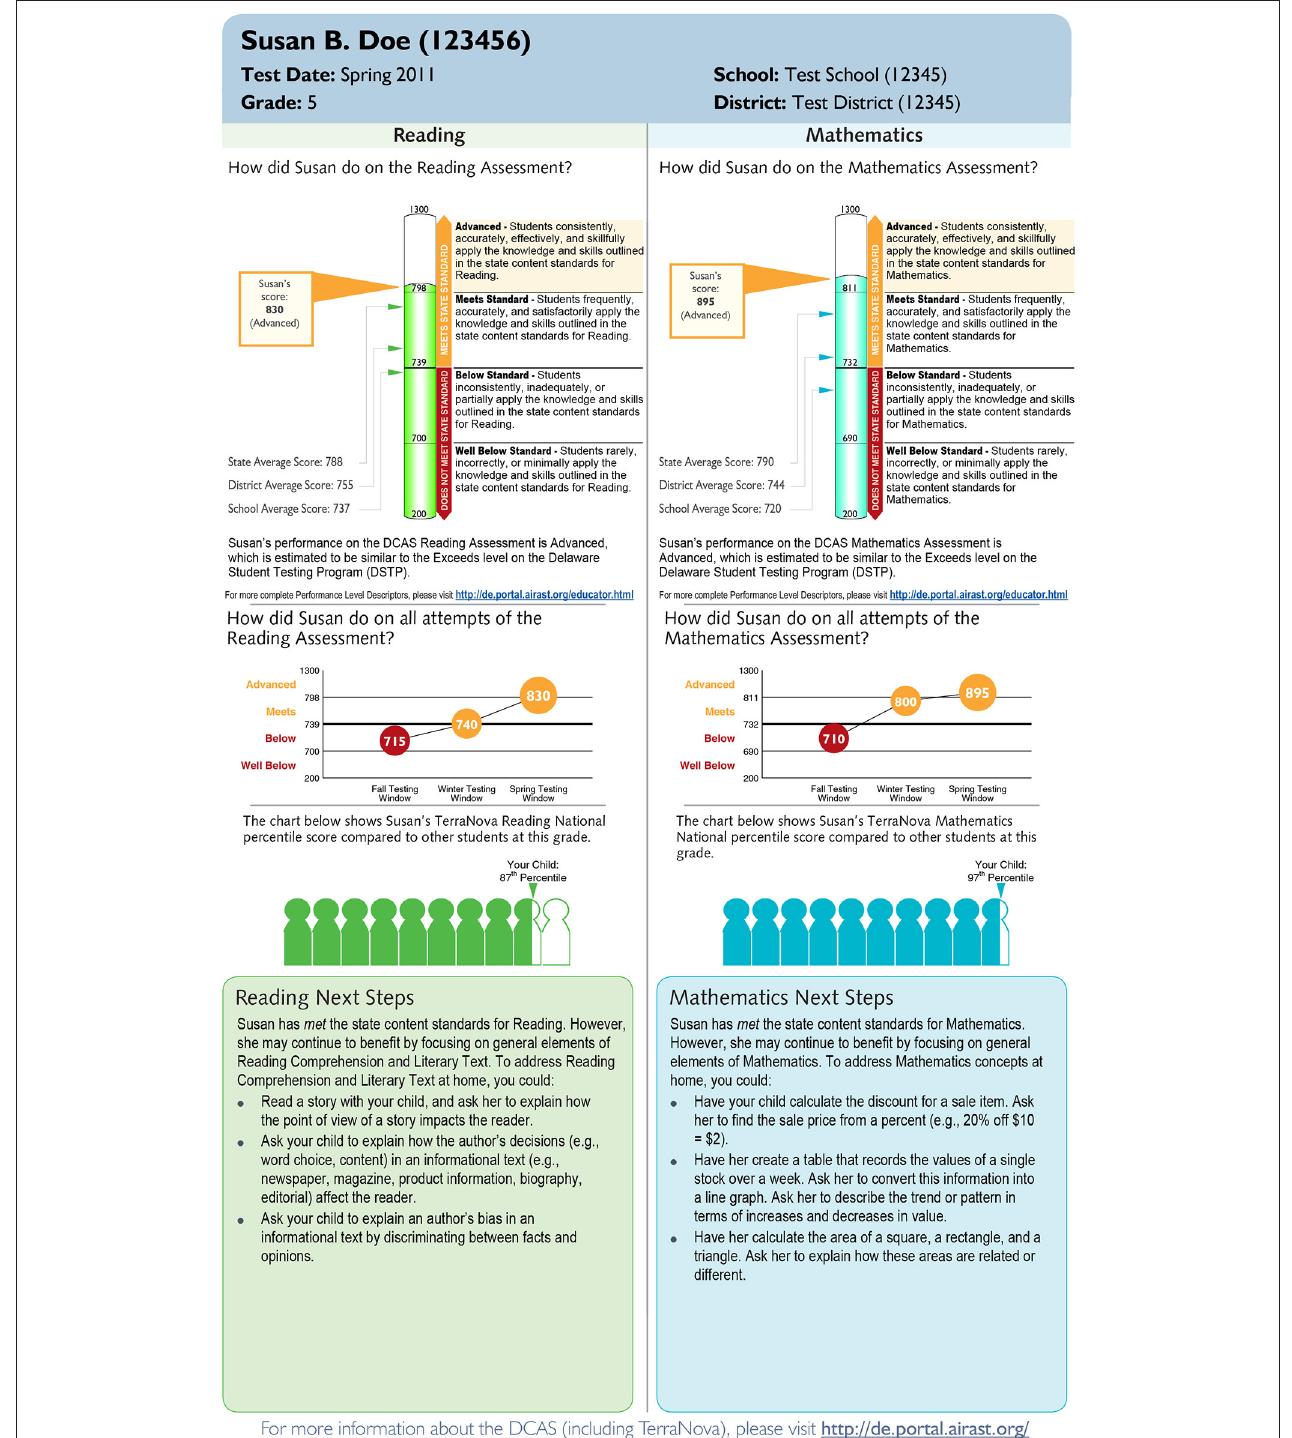
FIGURE 7 | The space on the Delaware individual student report was dedicated entirely to student performance and next steps to be taken. Used by permission of the Delaware Department of Education. All rights reserved.